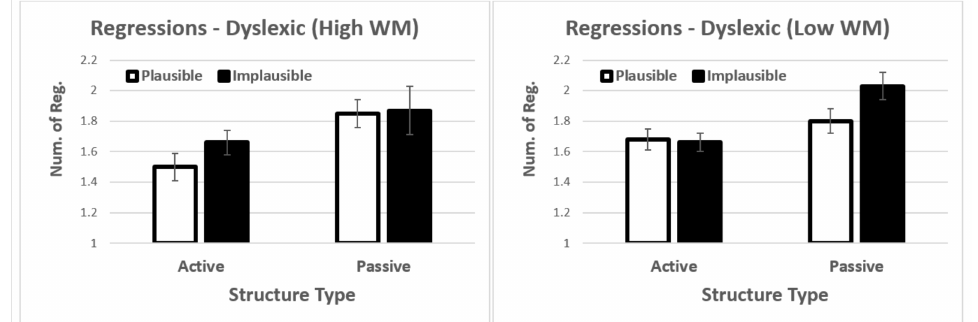
Figure 7. Interaction between structure type, plausibility, and working memory. Error bars show the standard error of the